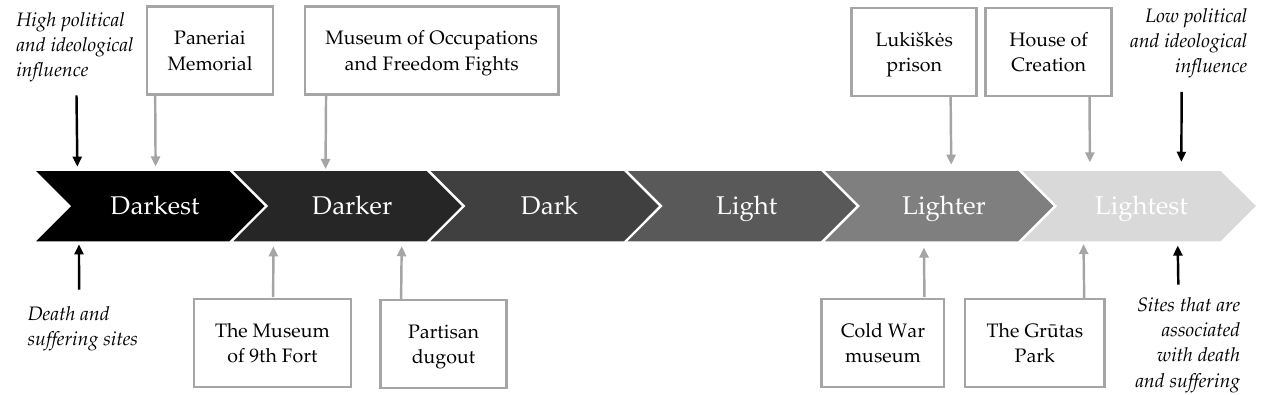
Figure 17. Lithuanian dark tourism spectrum, based on Stone (2006) heritage management model.